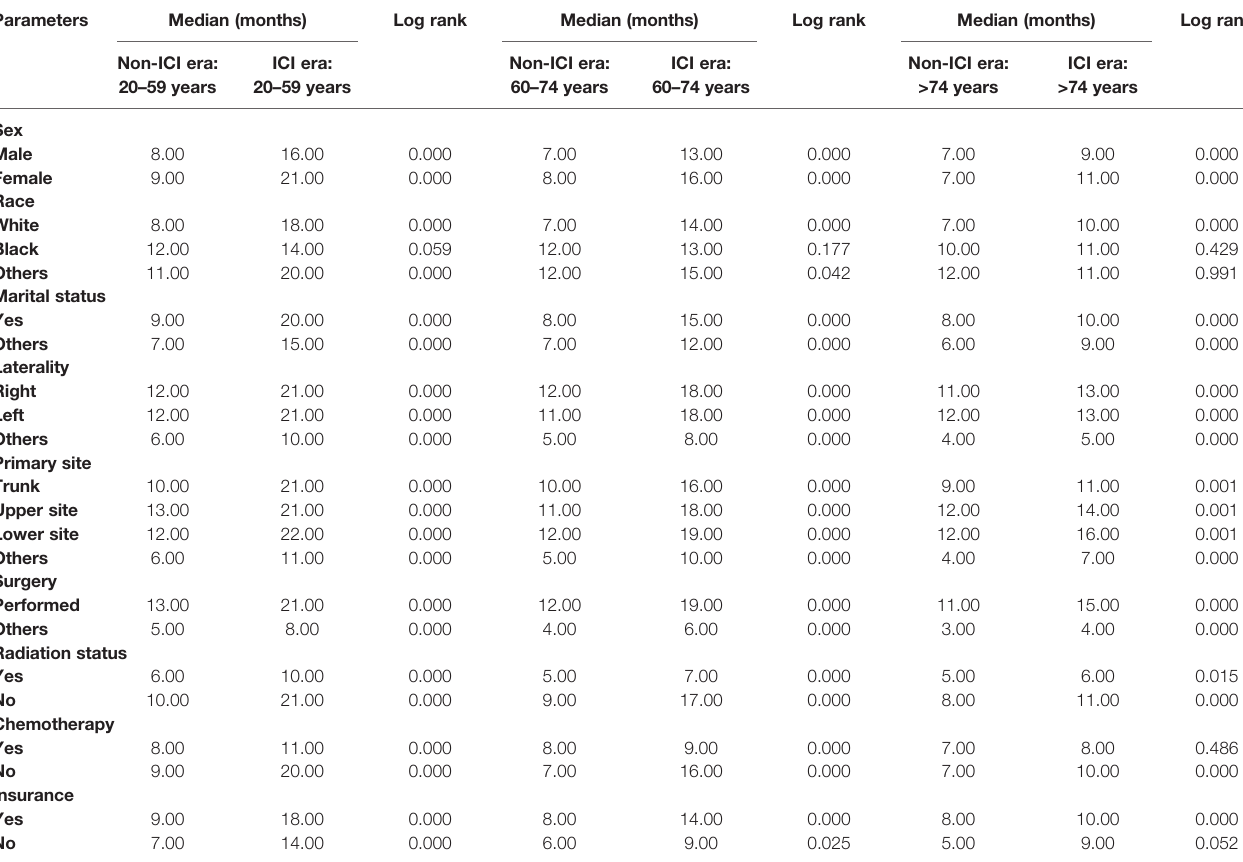
TABLE 2 | Survival patterns of the age groups in the non-immunotherapy and the immunotherapy era.